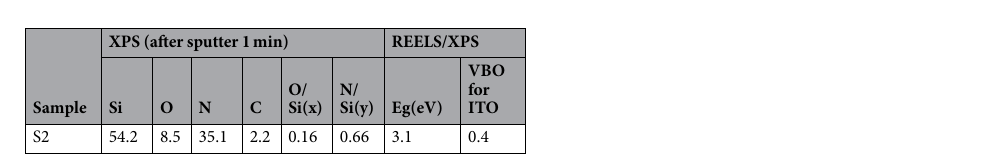
Table 1. Composition and electrical properties of Si-rich SiOxNy samples using AES, XPS and